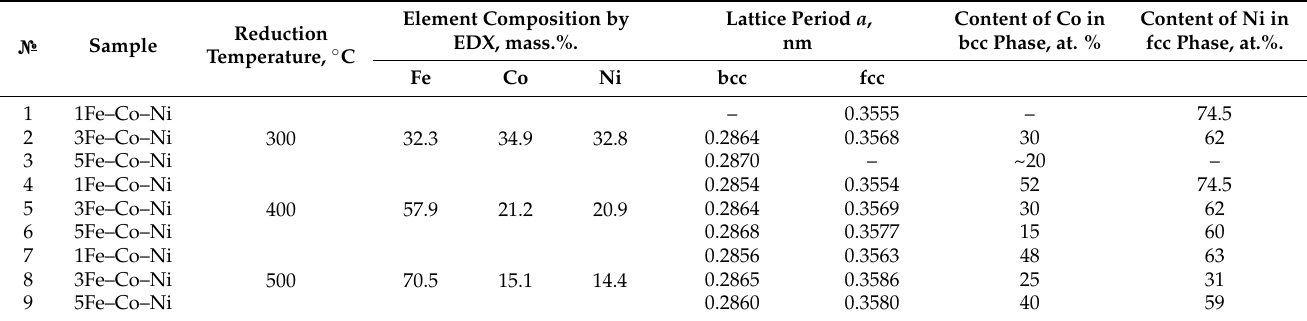
Table 1. Co and Ni content in iron-based nanocomposites.